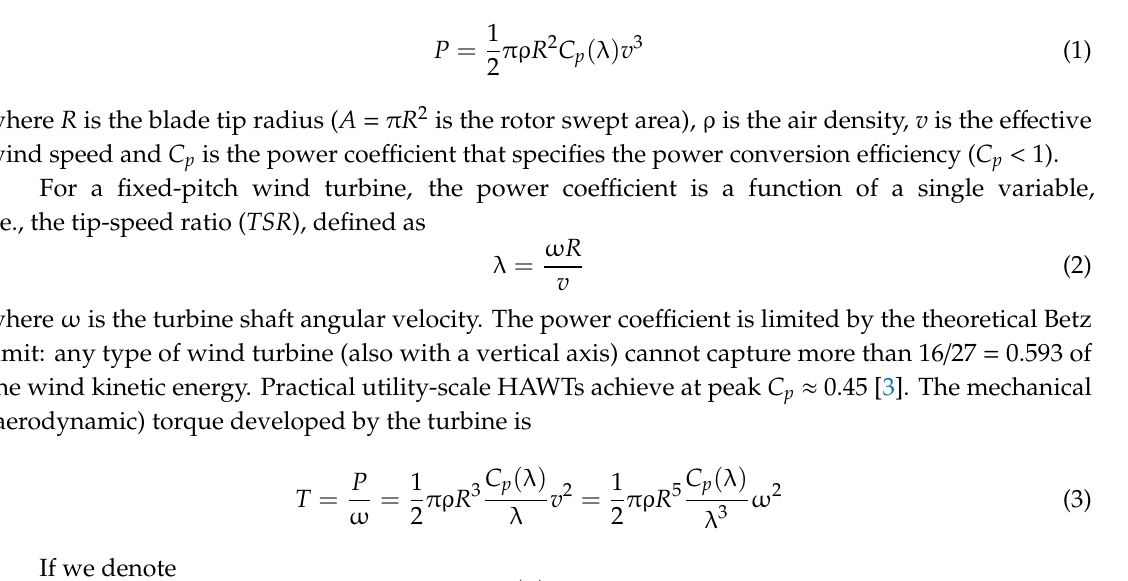
Figure 1. Configuration of a gearless permanent magnet synchronous generator (PMSG)-based wind energy conversion system (WECS) connected to a grid through back-to-back voltage source converters (VSCs) with schematic block diagram of the converters’ control.